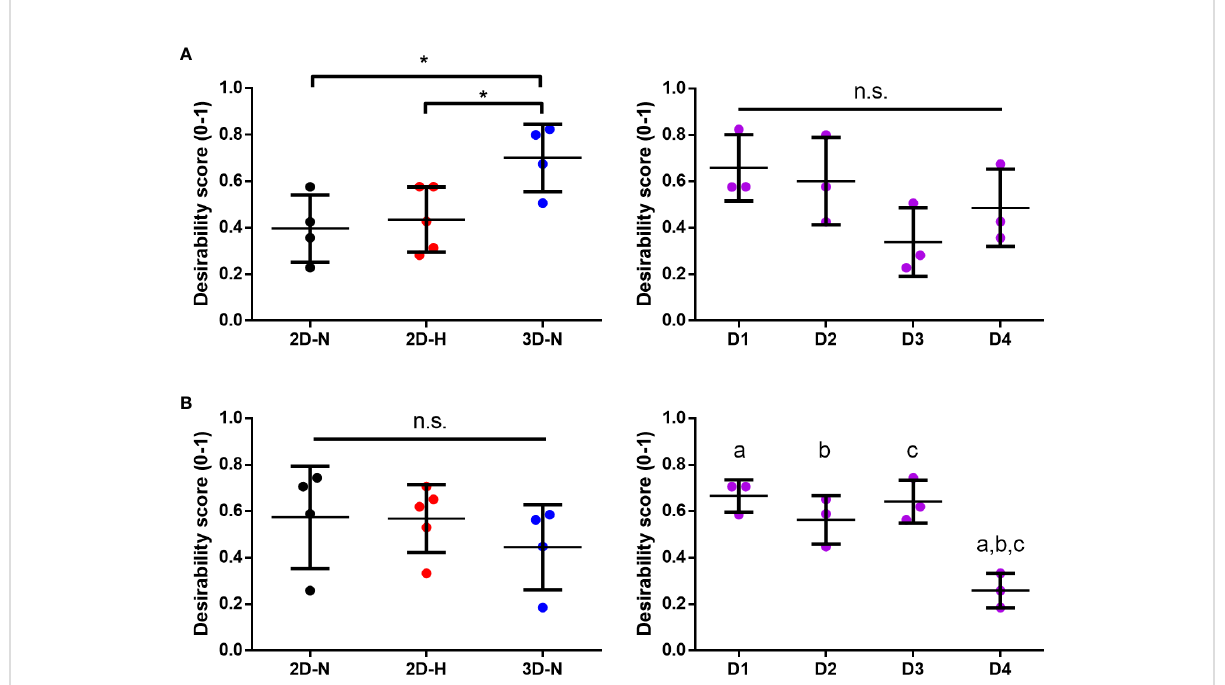
FIGURE 7 Statistical rankings of matrix of putative CQAs ranked different CPP conditions known to enhance MSC potency, and donors for optimal immunomodulation and angiogenic functionalities. Desirability analysis was performed on putative CQAs selected for evaluation of immunomodulatory (A) and angiogenic (B) functionalities. (A) Desirability pro fi ling ranked 3D-N CPP conditions higher than 2D-H and 2D-N for overall immunomodulatory desirability scores, while scores were similar across donors. (B) Desirability pro fi ling ranked Donors 1, 2, and 3 higher than Donor 4 for overall angiogenic desirability scores, while scores were similar across various CPPs. One-way ANOVA, Tukey post-hoc test. *p<0.05. Donors sharing same letter indicate statistically signi fi cant differences (p<0.05). Horizontal bars: group mean, error bars: standard deviation. 3D-N, 3D Normoxic culture; 2D-N, 2D Normoxic culture; 2D-H, 2D Hypoxic culture, n.s, non-signi fi